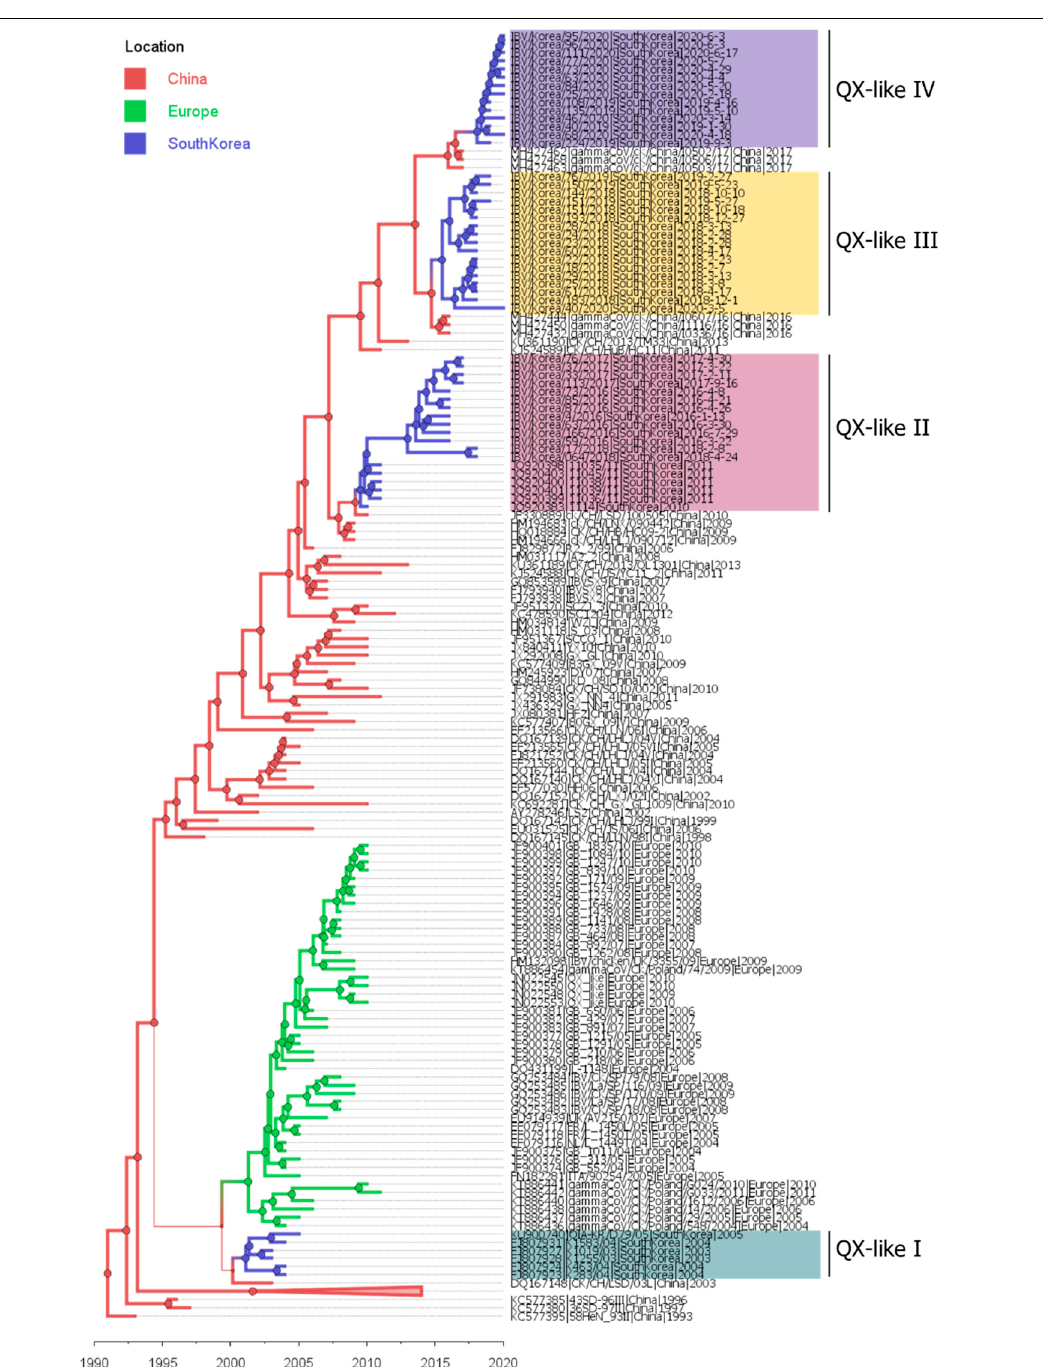
Figure 2. The maximum clade credibility tree of the isolates clustered into the South Korean QX-like IBV subgroups. The color of the branches and nodes (circle) indicates the isolate’s location of origin (red, China; green, Europe; blue, South Korea). The branch weight and size of the node depend on the location probability. Taxa divided by background color indicate the QX-like subgroups, QX-like IV to I, in order from the top.